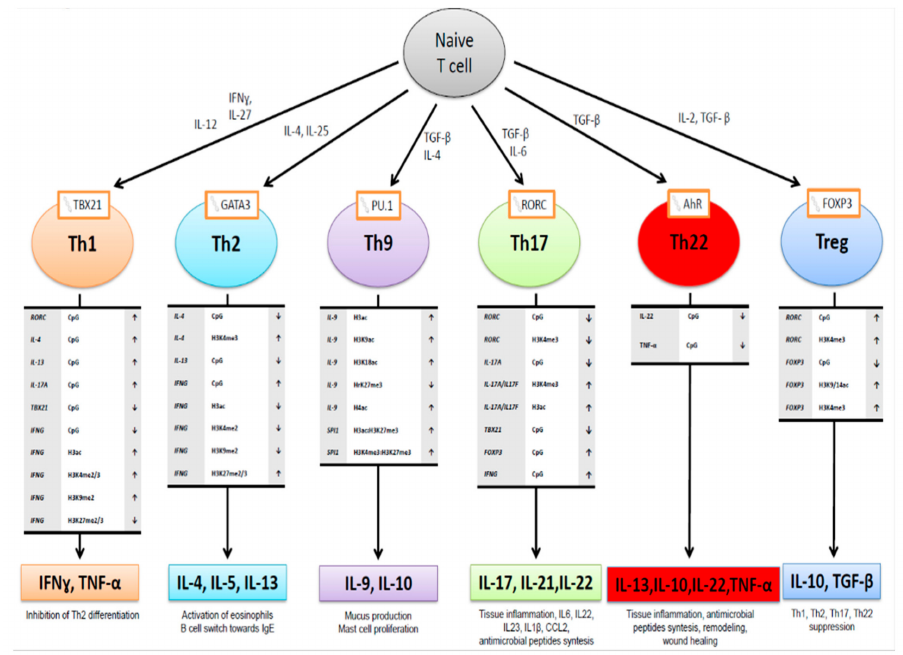
Figure 2. Epigenetic change in chromatin (promoter methylation, histone methylation, and acetylation) observed in the di ff erentiation process of T helper cells subpopulations (from Potaczek et al. 2017 modified